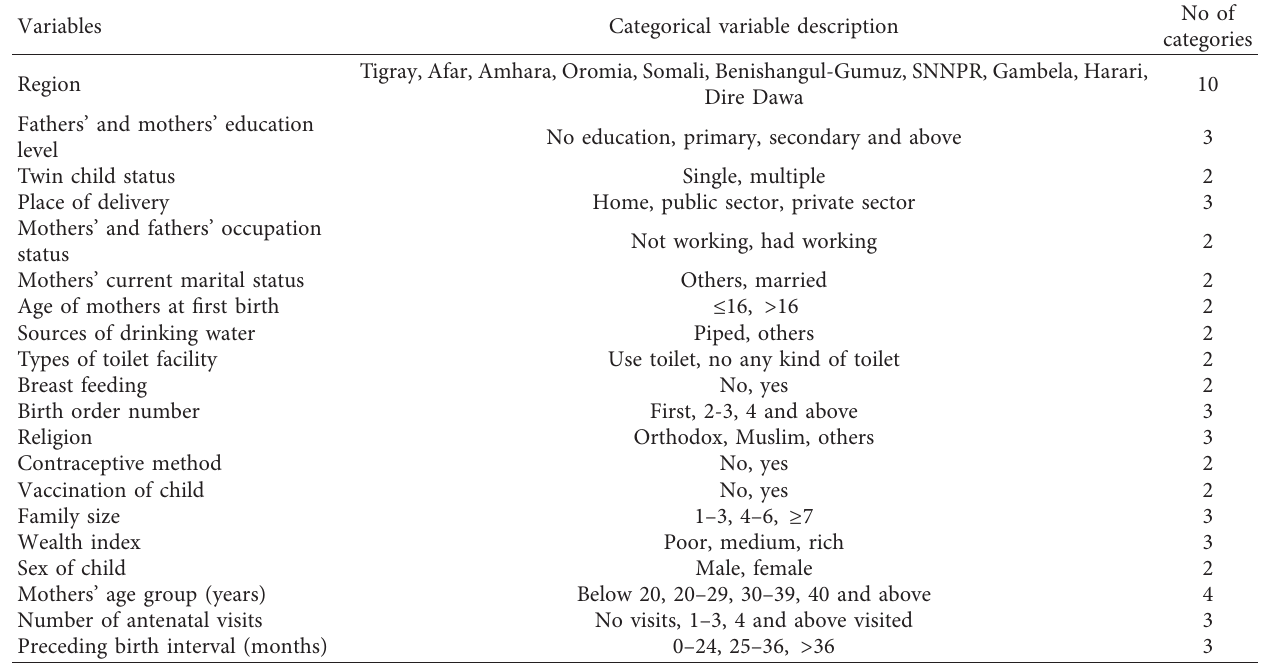
Table 1: Description of independent variables included in the